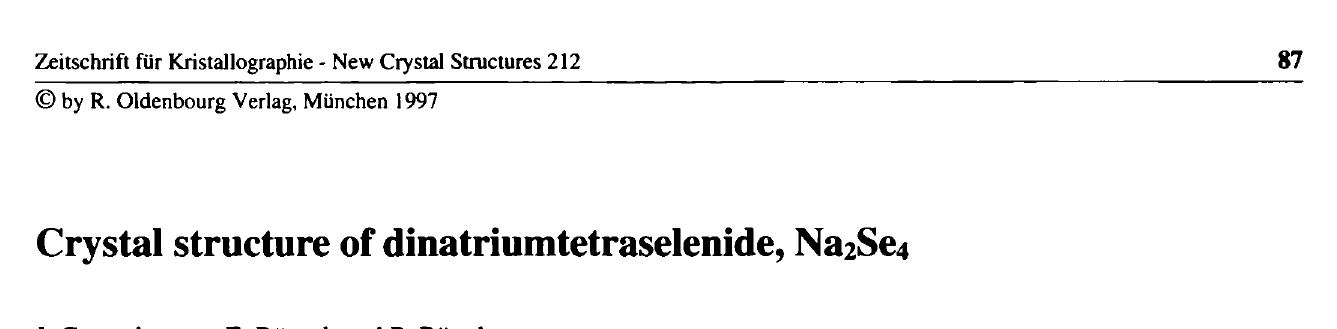
Na2Se4 crystallizes isotypic with Na2S4 (see ref. 2). It is charac- terized by Se4 2 chains (gauche conformation; torsion angle 97.5( 1 two crystallographically independend sodium and selenium atoms. Each Na(l) is surrounded tetrahedrally by 4 Se(l), and addi- tionally by 2 Se(2), which are about 0.3 Â further away. Na(2) is surround in a more distorted manner by [4 Se(l) + 2 Se(2)] in the first coordination sphere.